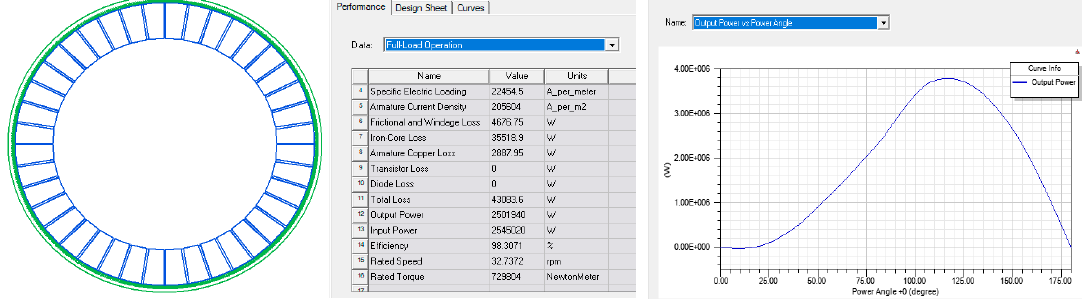
Figure 5. Results of the calculation of the brushless direct current motor (BLDC) with tangential magnets in RMxprt mode.